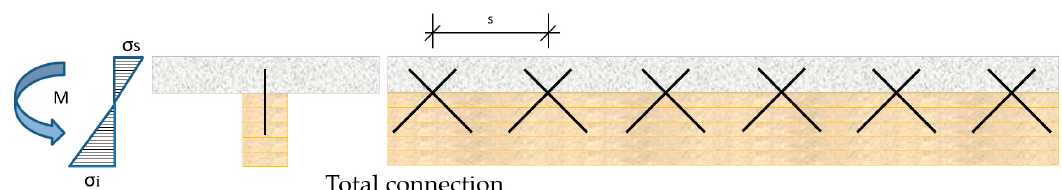
Figure 10. Diagram of wooden joist-compression layer connections.